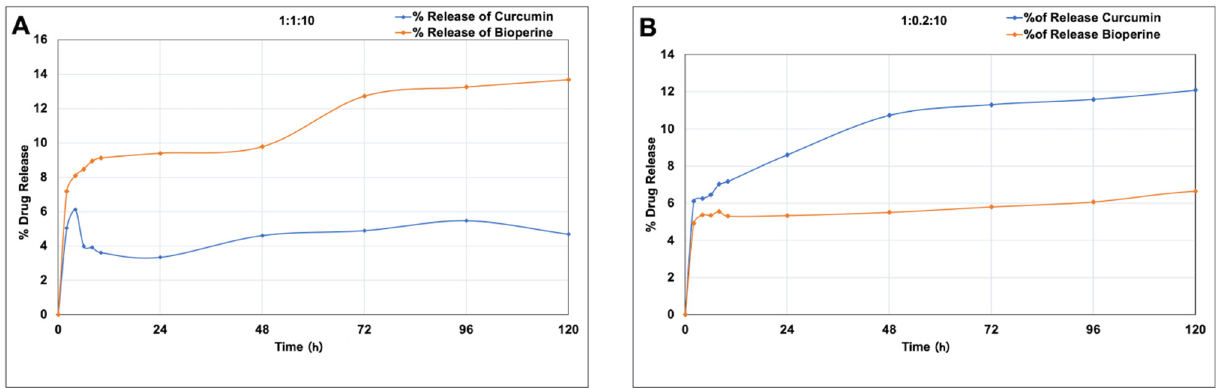
Pharmaceutics 2021 , 13 , x Figure 2. XRD spectra of free Bioperine, free curcumin, curcumin-Bioperine PLGA NPs, and blank PLGA NPs.